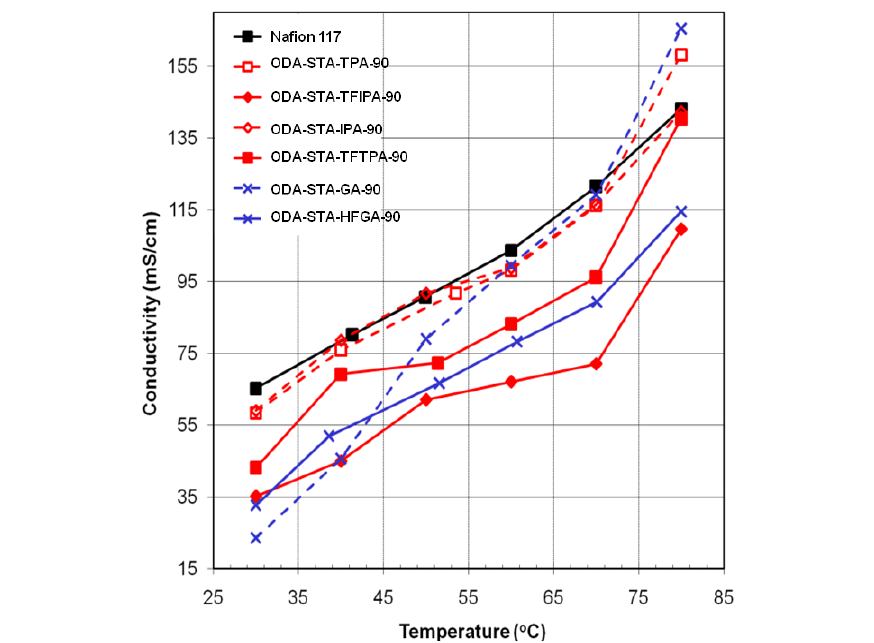
Figure 4. Proton conductivity of sulfonated poly(ether amide) membranes a